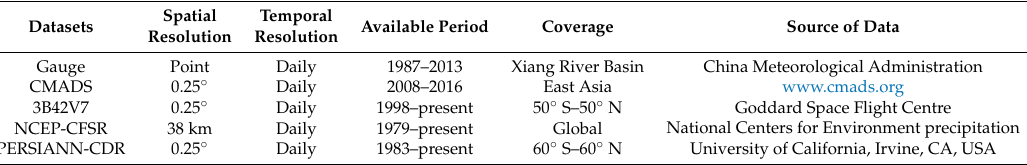
Table 1. Overview of precipitation